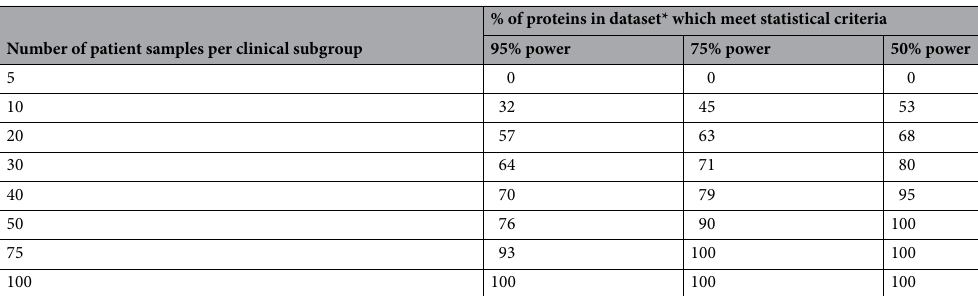
Table 3. Required number of patient samples per clinical subgroup and the percentage of proteins in the SWATH-MS dataset which would meet the statistical criteria at a statistical power of 95%, 75% or 50%. The total dataset consisted of 5108 proteins. The calculations were based on a twofold change and a 0.1 Bonferroni adjusted P-value.